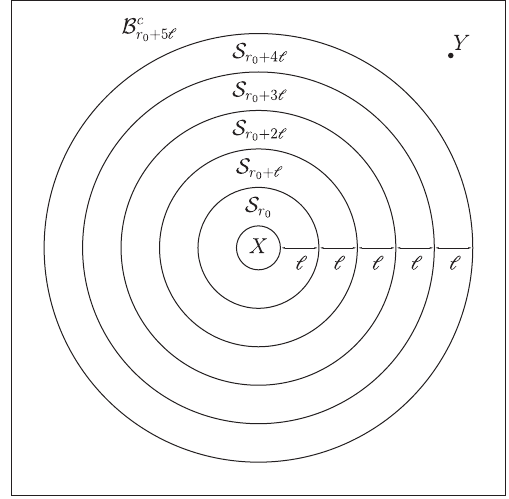
and five shells S for r 0 r is supported on Y , Y r 0 þ 5 l